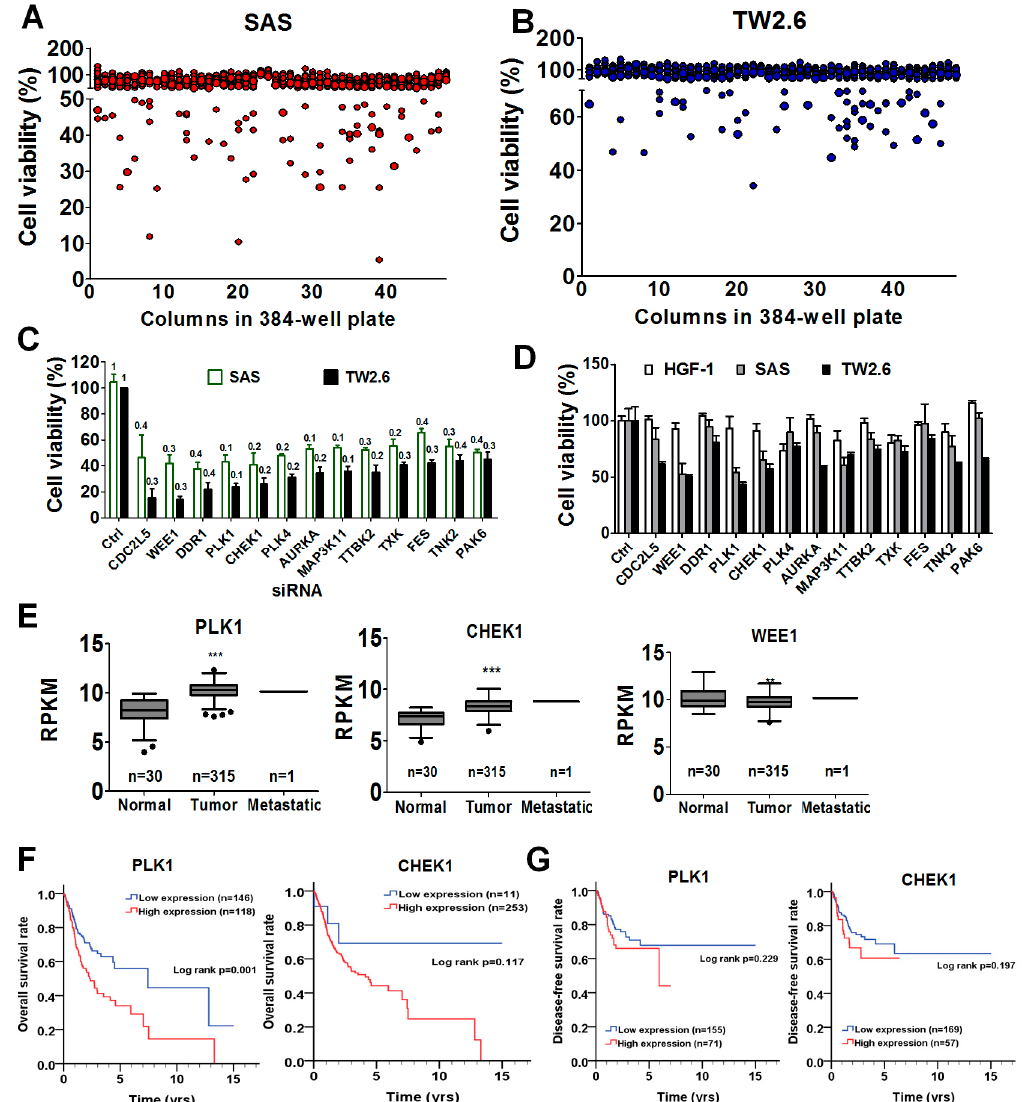
Figure 1. Kinome siRNA (small interfering RNA) library screening for kinases required for OSCC (oral squamous cell carcinoma) cell proliferation. ( A ) SAS and ( B ) TW2.6 cells were seeded and transfected with the arrayed kinome siRNA library (5 nM pooled siRNAs for each gene) for 72 h. Cell viability was measured by a CellTiter-Glo assay (Promega, Madison, WI, USA). ( C ) Cells were transfected with the top 13 ranked siRNAs (as listed) that reduced cell viability in both SAS (white) and TW2.6 (black) cells. The mRNA level in each gene was determined by real-time PCR to confirm the knockdown efficiency of siRNA using scramble siRNA (Ctrl) as normalized controls. The fold change of mRNA level in each siRNA knockdown is indicated above each bar. ( D ) The siRNAs were further counter-assayed with normal human gingival cells (HGF-1). The selective effects of silencing three genes, namely, PLK1, CHEK1, and WEE1 , are shown. ( E ) The expression of the three genes in OSCC patients is presented as reads per kilobase of transcript per million mapped reads (RPKM) to compare its transcription level between tumor tissues and adjacent normal tissues according to the TCGA (The Cancer Genome Atlas) dataset. * p < 0.05, ** p < 0.01, *** p < 0.001, tumor tissues vs. the adjacent normal tissues. ( F ) Kaplan-Meier plots were used to evaluate the gene association with overall survival in patients with OSCC. ( G ) Kaplan-Meier plots were used to evaluate the gene association with disease-free survival in patients with OSCC.